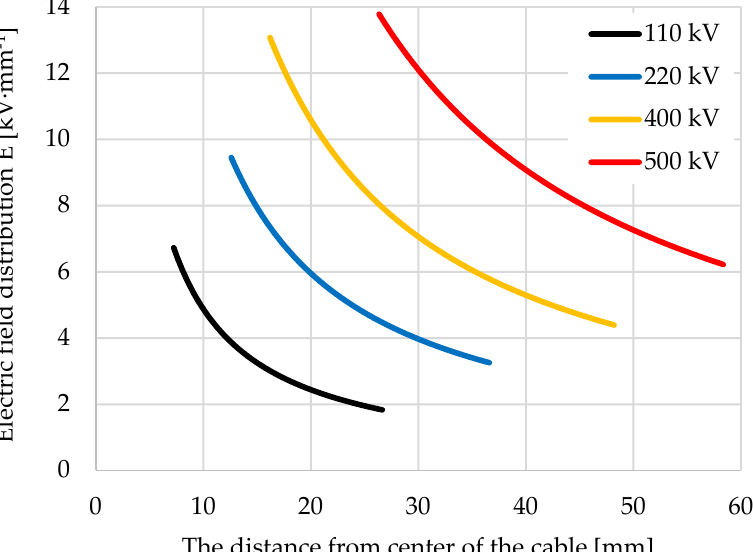
Figure 1. Electric field distribution E in XLPE insulation as a function of radius r for various high- voltage cables (110, 220, 400, and 500 kV).